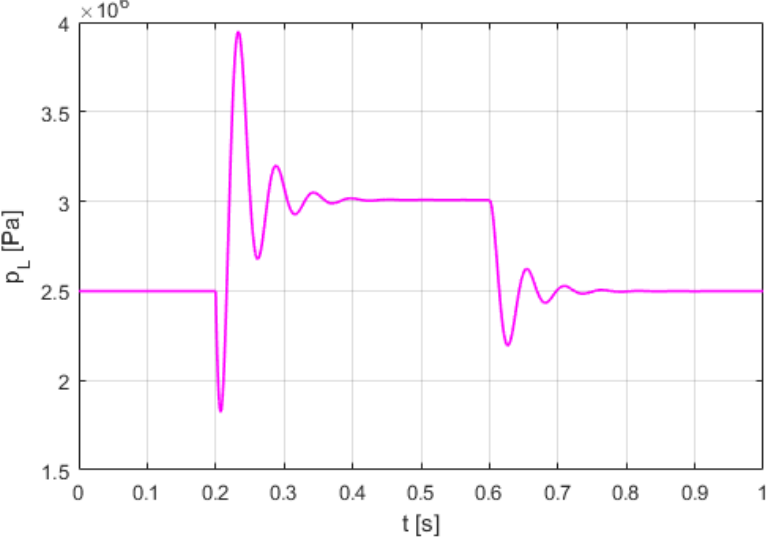
Figure 16. Dynamic response of the shock pressure p L ( t ) of an SHA damped by an HSD with instantaneous rise and fall shock force F .